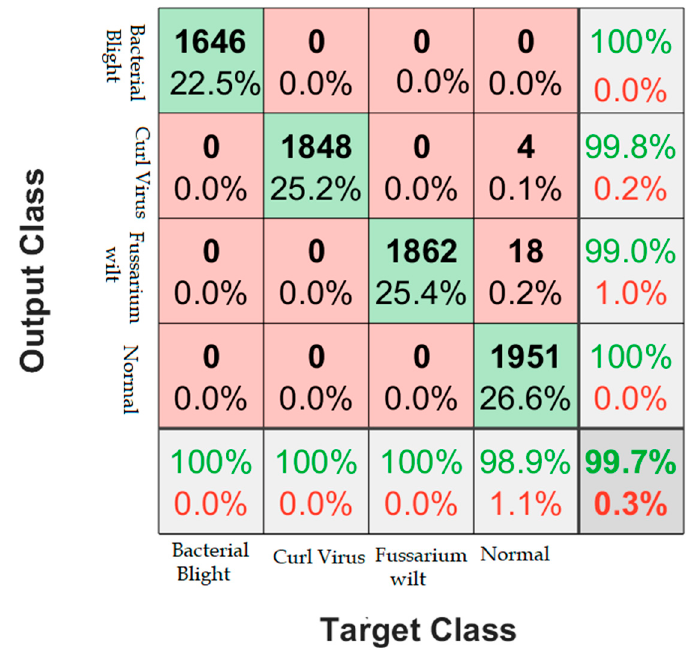
Figure 5. Multi-class confusion matrix of cotton leaf infection.